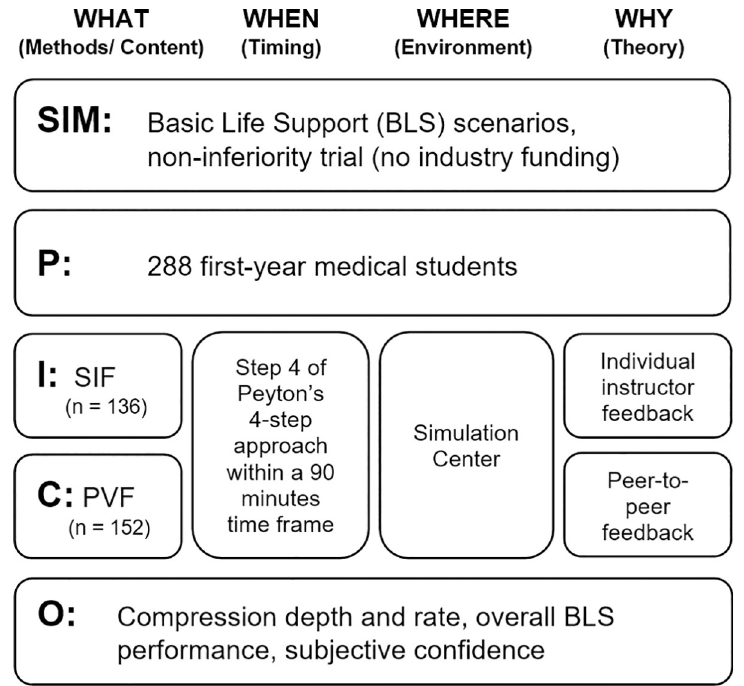
Fig 2. SimPICO based on Raemer et al. [25]. Notes . SIM: Simulation study, P: Population, I: Intervention, C: Comparator, O: Outcome; SIF: Standard Instructor Feedback; PVF: Peer Video Feedback.